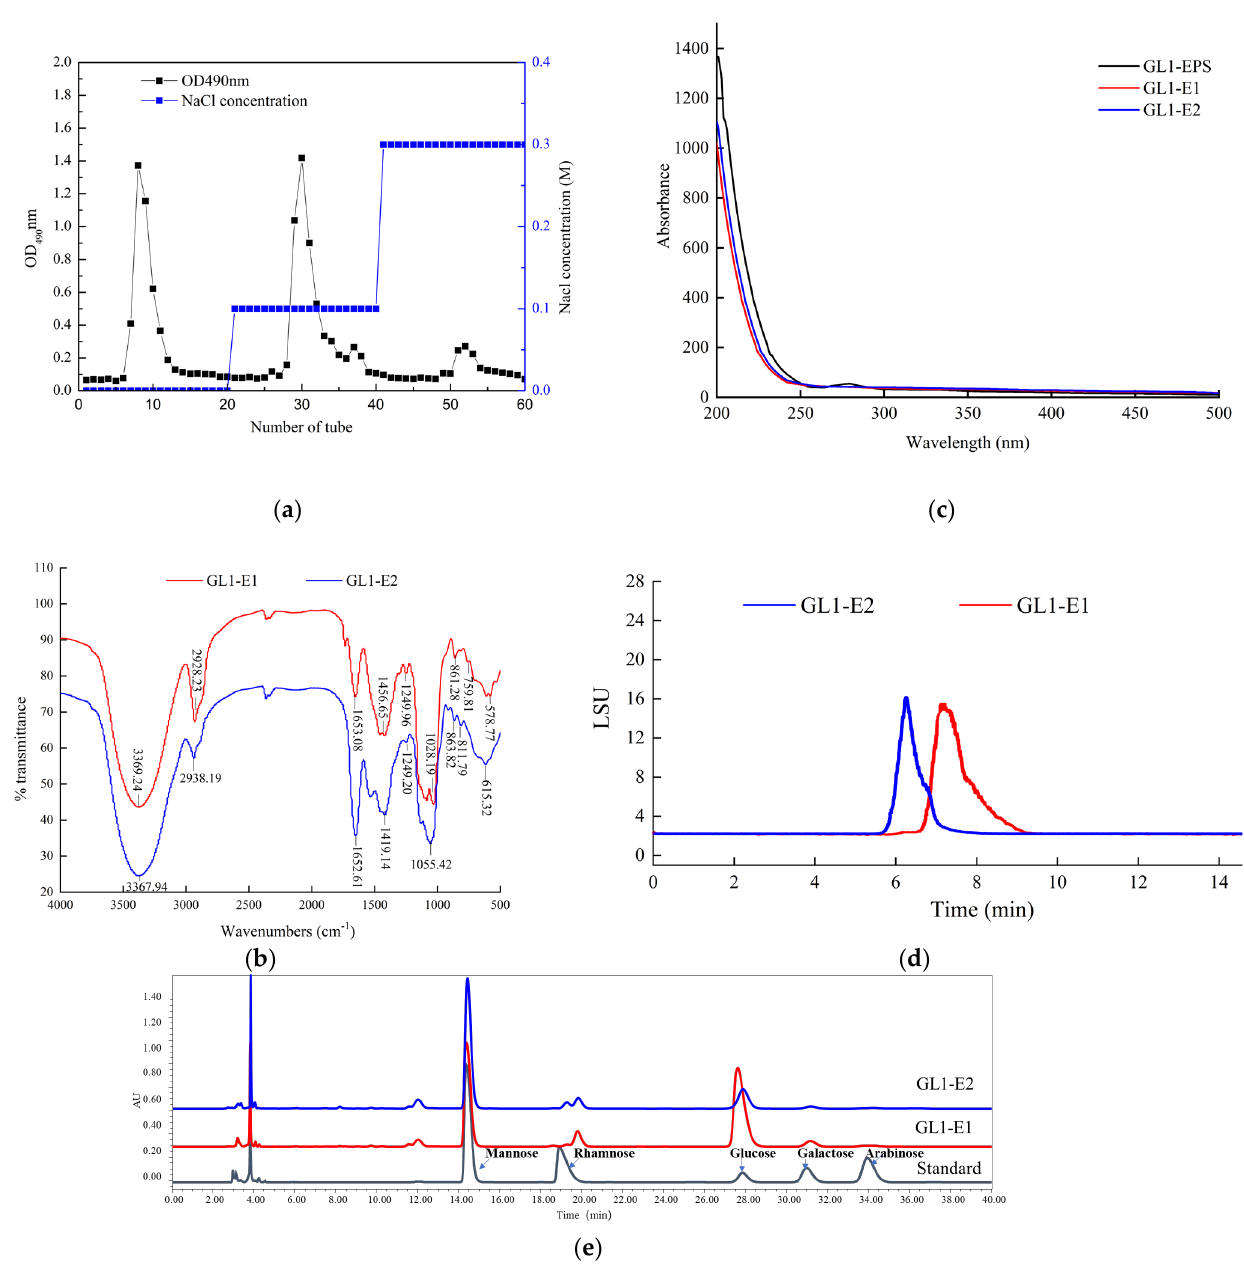
Figure 2. Elution curves of the crude EPS ( a ), UV spectra ( b ), FT-IR spectra ( c ), Mw distributions ( d ), and monosaccharide compositions ( e ) of GL1-E1 and GL1-E2 derived from L. paracasei GL1, respec- tively.